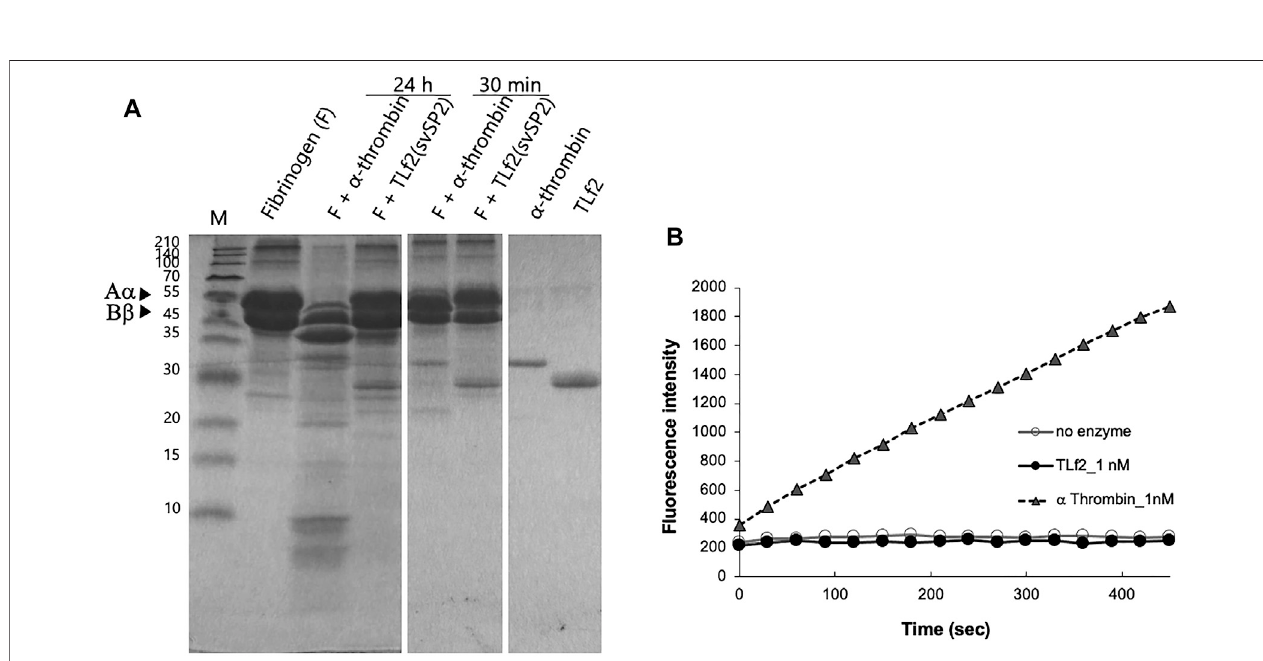
FIGURE 4 | Coparison of enzymatic activity of TLf2 with α thrombin on the fi brinogen (A) and synthetic substrate (B) . (A) Fibrinogen (F) was loaded on SDS-PAGE afterincubatingwith/withoutTLf2or α thrombinfor30 minor12 h. (B) Synthetic fl uorogenicsubstrate,Boc-Val-Pro-Arg-MCA(200 μ M),wasused.Negativecontrolwas carried out without